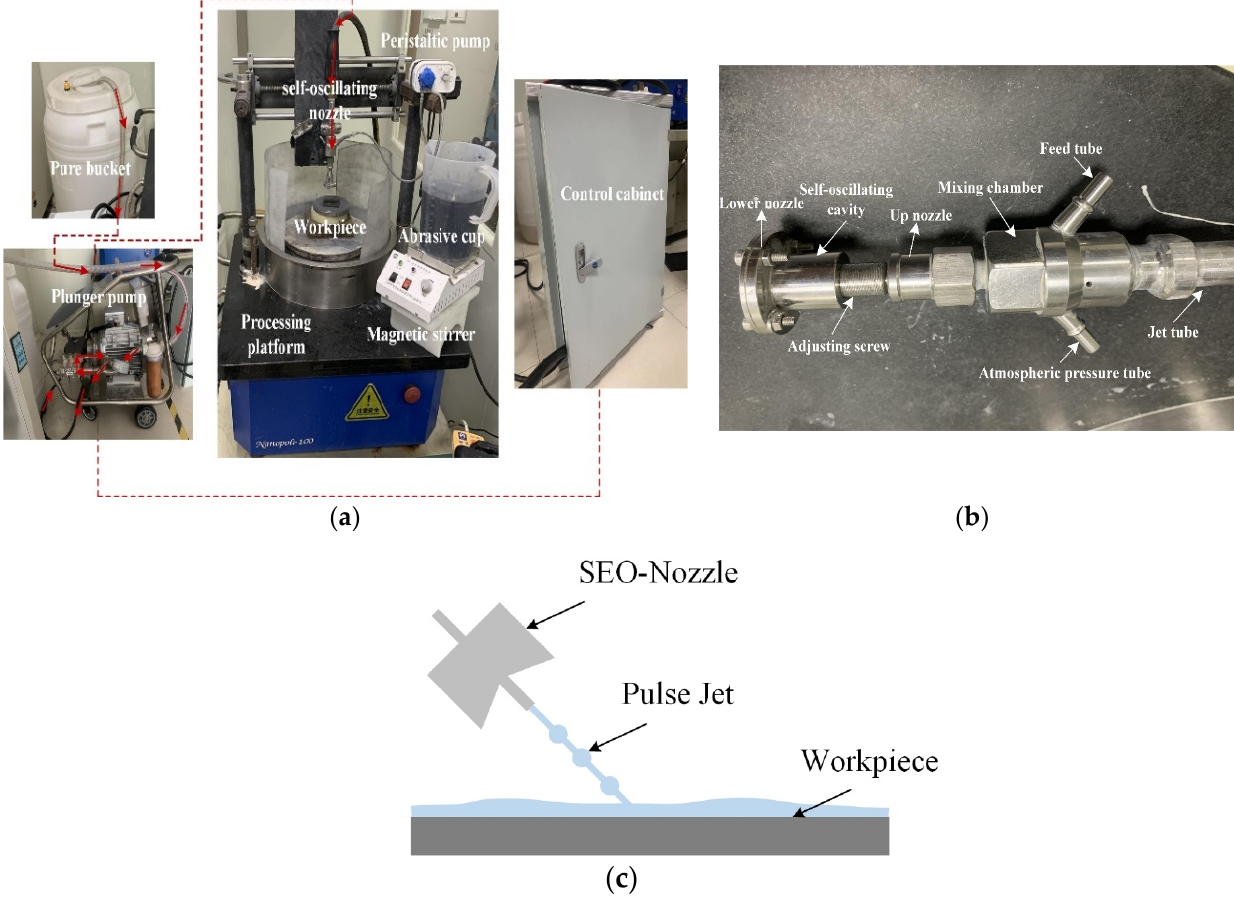
Figure 4. Self-excited oscillating abrasive water jet polishing device. The physical image of the experimental platform ( a ). Self-excited oscillating nozzle ( b ). Schematic illustration of SEO-AWJM ( c ).